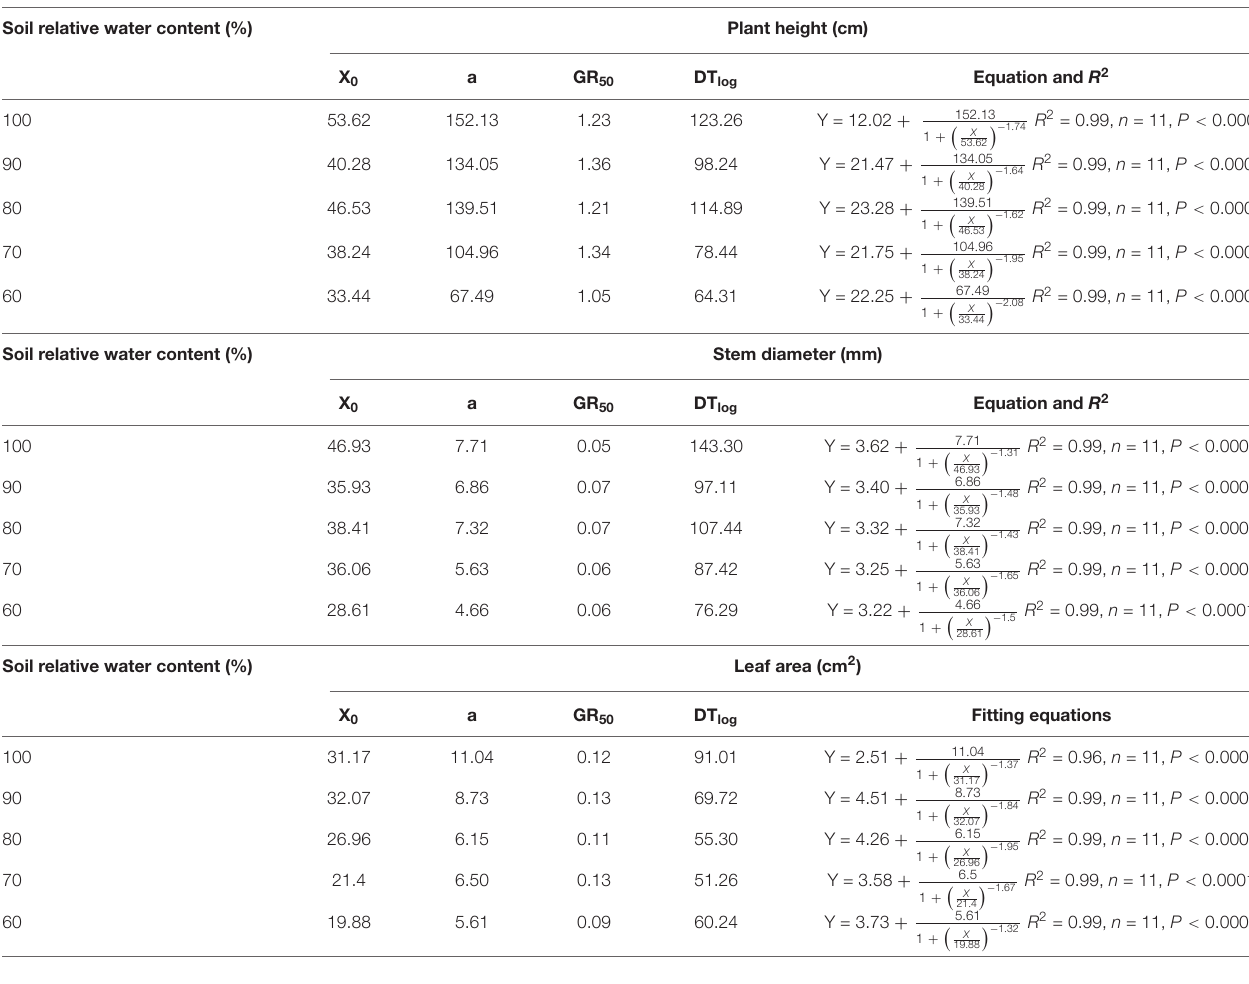
TABLE 3 | Effect of different water supplies on N, P, and K contents in plant leaves, stems, and roots. Soil relative water content